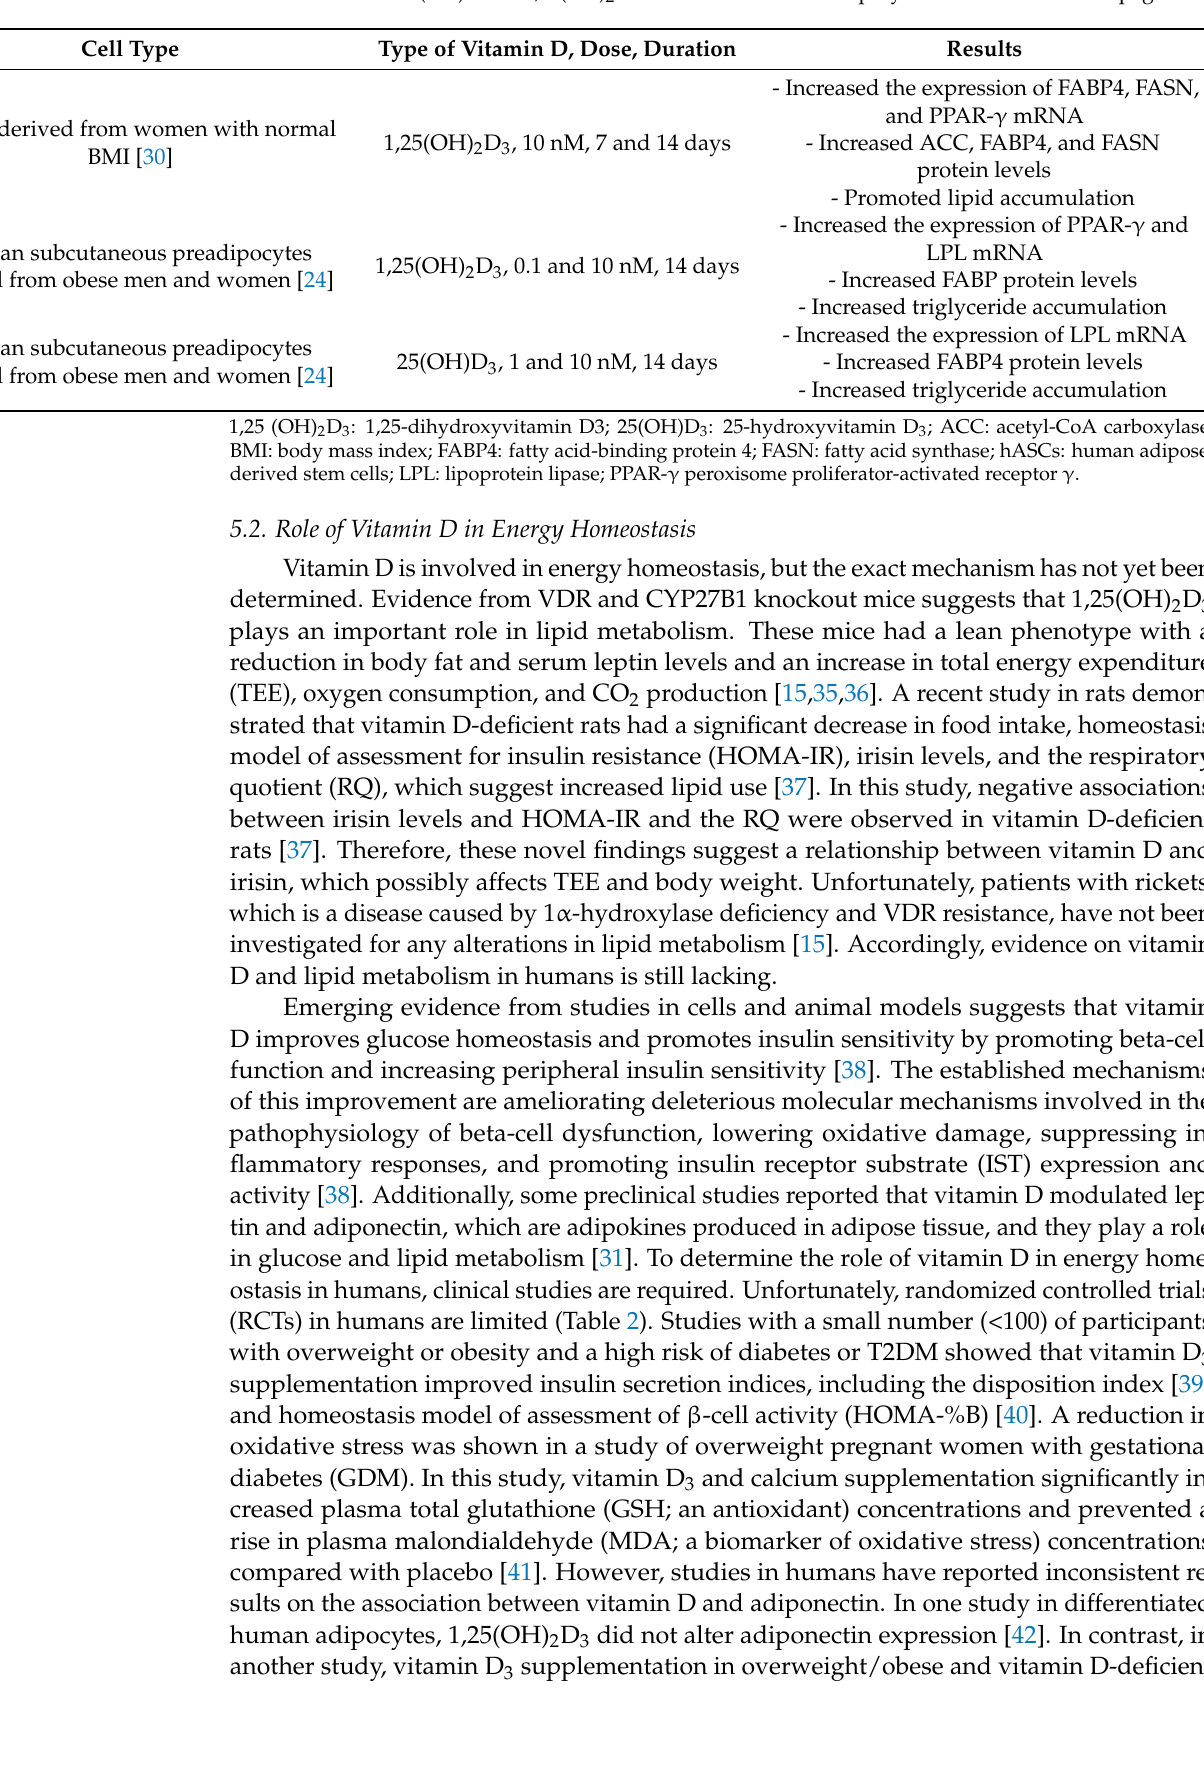
Table 1. Effects of 25(OH)D and 1,25(OH) 2 D treatments on human adipocyte differentiation and